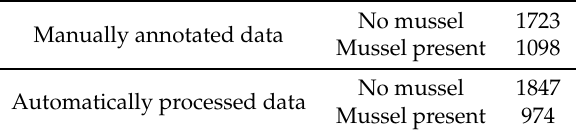
Table 2. Comparison of frame counts with and without aMussels present.